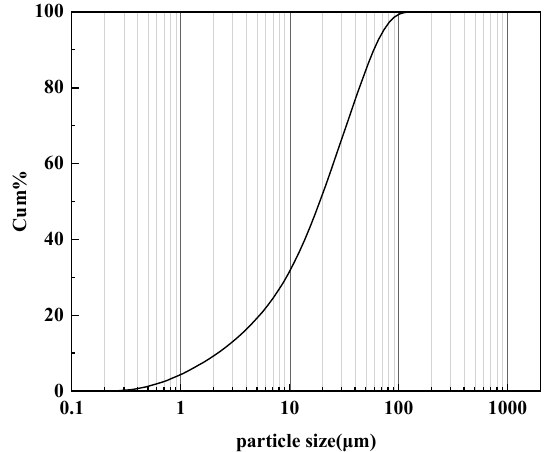
Figure 1. Schematic diagram of the physical dimensions and size of the X70 steel sample.